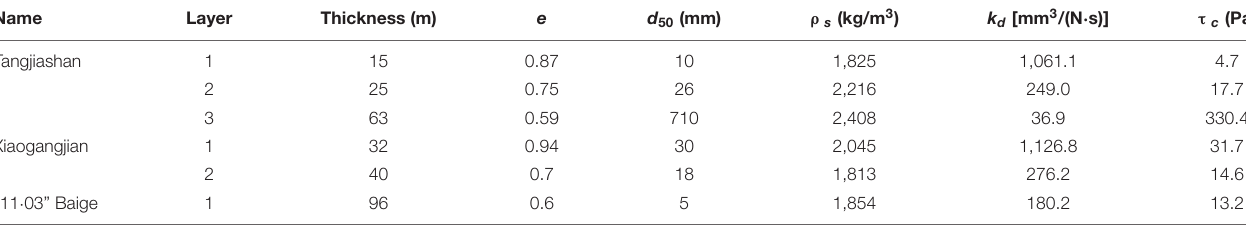
TABLE 5 | Input parameters for each layer of three landslide dams.